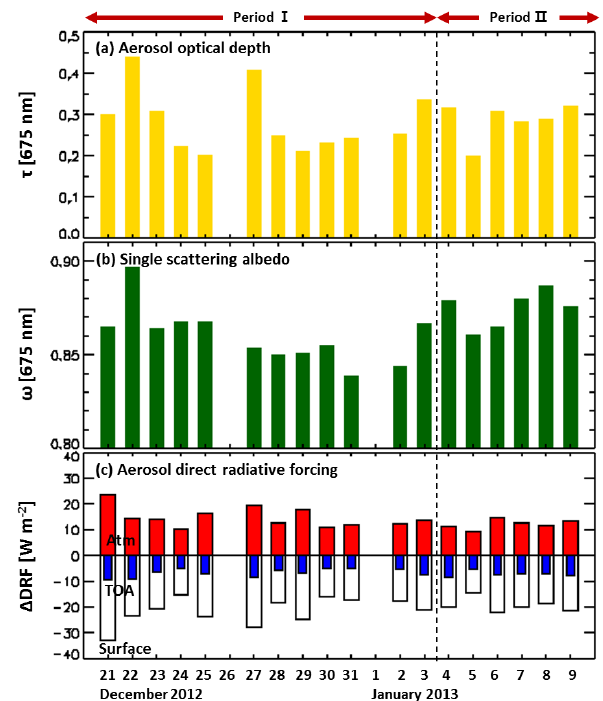
Figure 9. Daily variation in the (a) aerosol optical depth, (b) sin- gle scattering albedo, and (c) estimated aerosol radiative forcing at the surface, atmosphere (Atm), and top of atmosphere (TOA) in the Kathmandu Valley from 21 December 2012 to 9 January 2013.